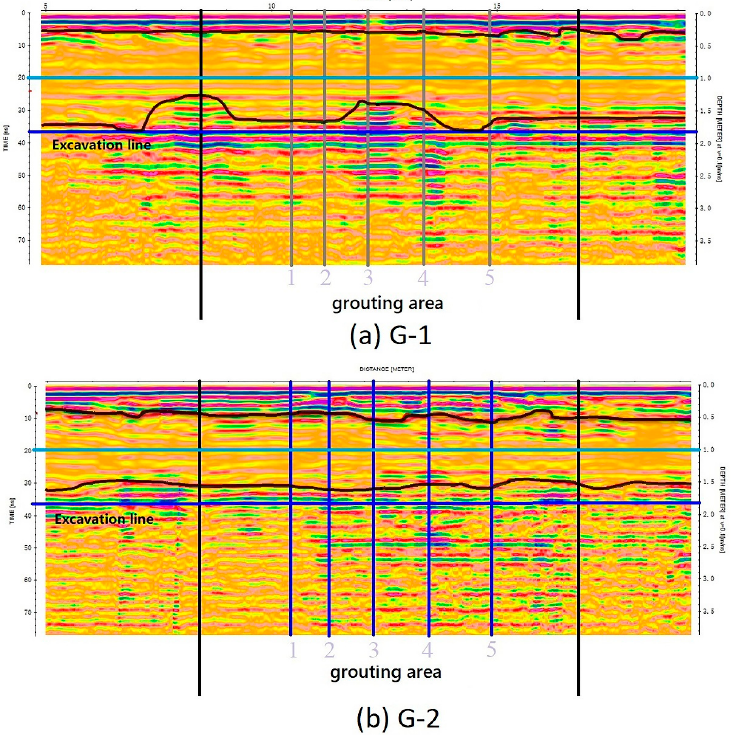
Figure 11. Photographs of GPR in the axial direction.